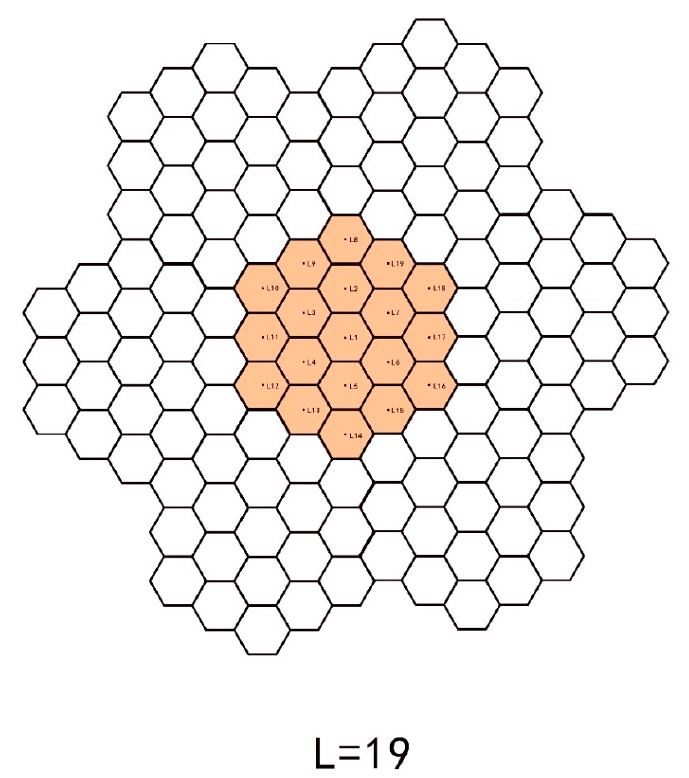
Figure 2. A cellular network composed of 19 hexagonal cells.